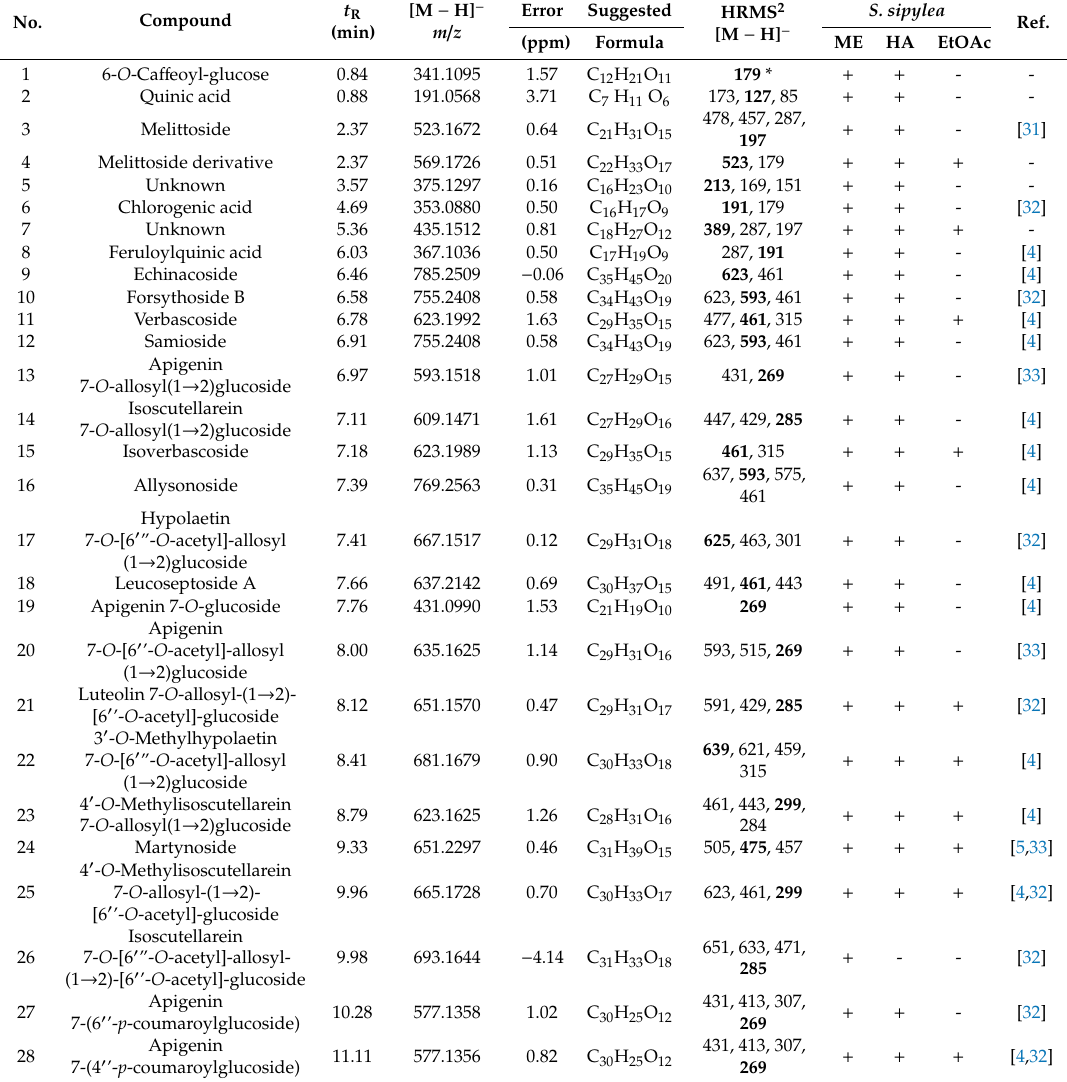
Table 3. Chemical components identified by UPLC-ESI(–)-HRMS in the methanol (ME), water / methanol (HA) and ethyl acetate (EtOAc) extracts of S. sipylea .